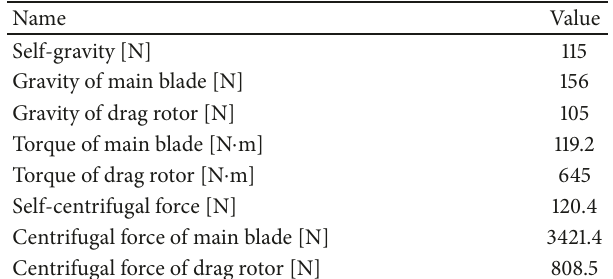
Table 5: Load distribution of beam.